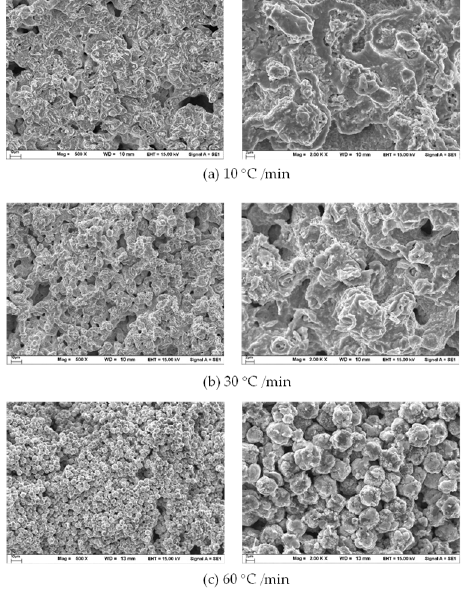
Figure 6. SEM images of sintered nano-copper clay with different heating rates at ( a ) 10 °C/min, ( b ) 30 °C/min, and ( c ) 60 °C/min.